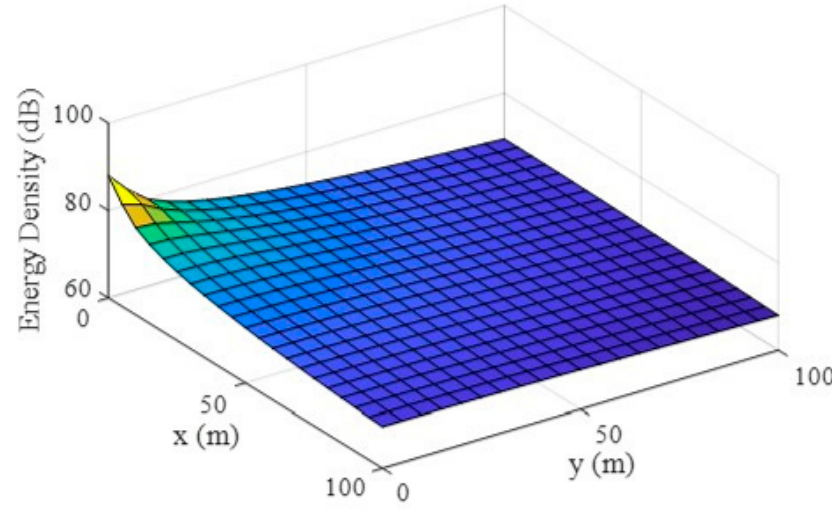
Figure 3. Energy response in frequency field. The reference energy is 10 − 12 J/m 2 .